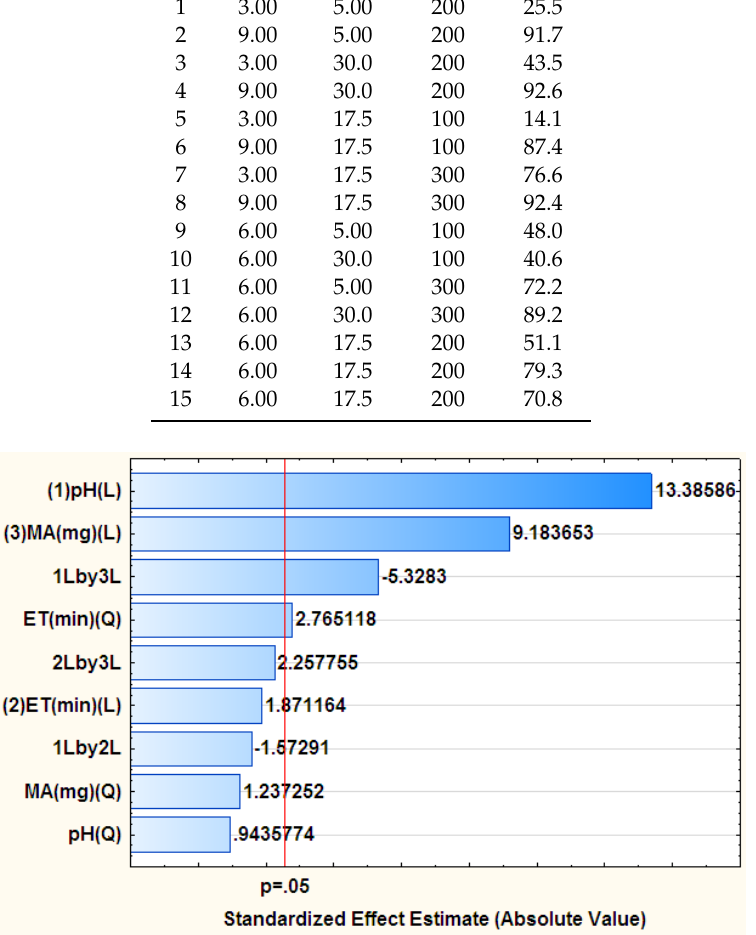
Figure 6. Chart of standardized estimated effects caused by investigated factors.